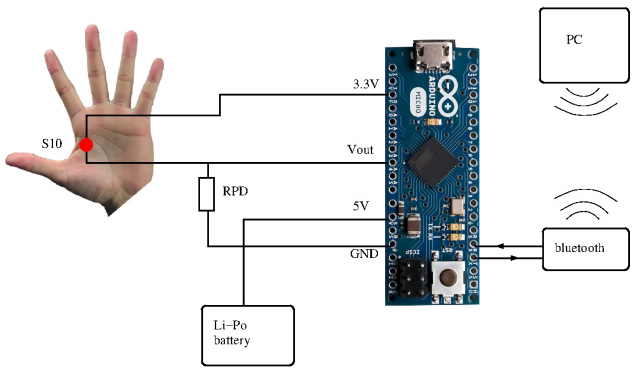
Figure 4. Diagram of data acquisition system